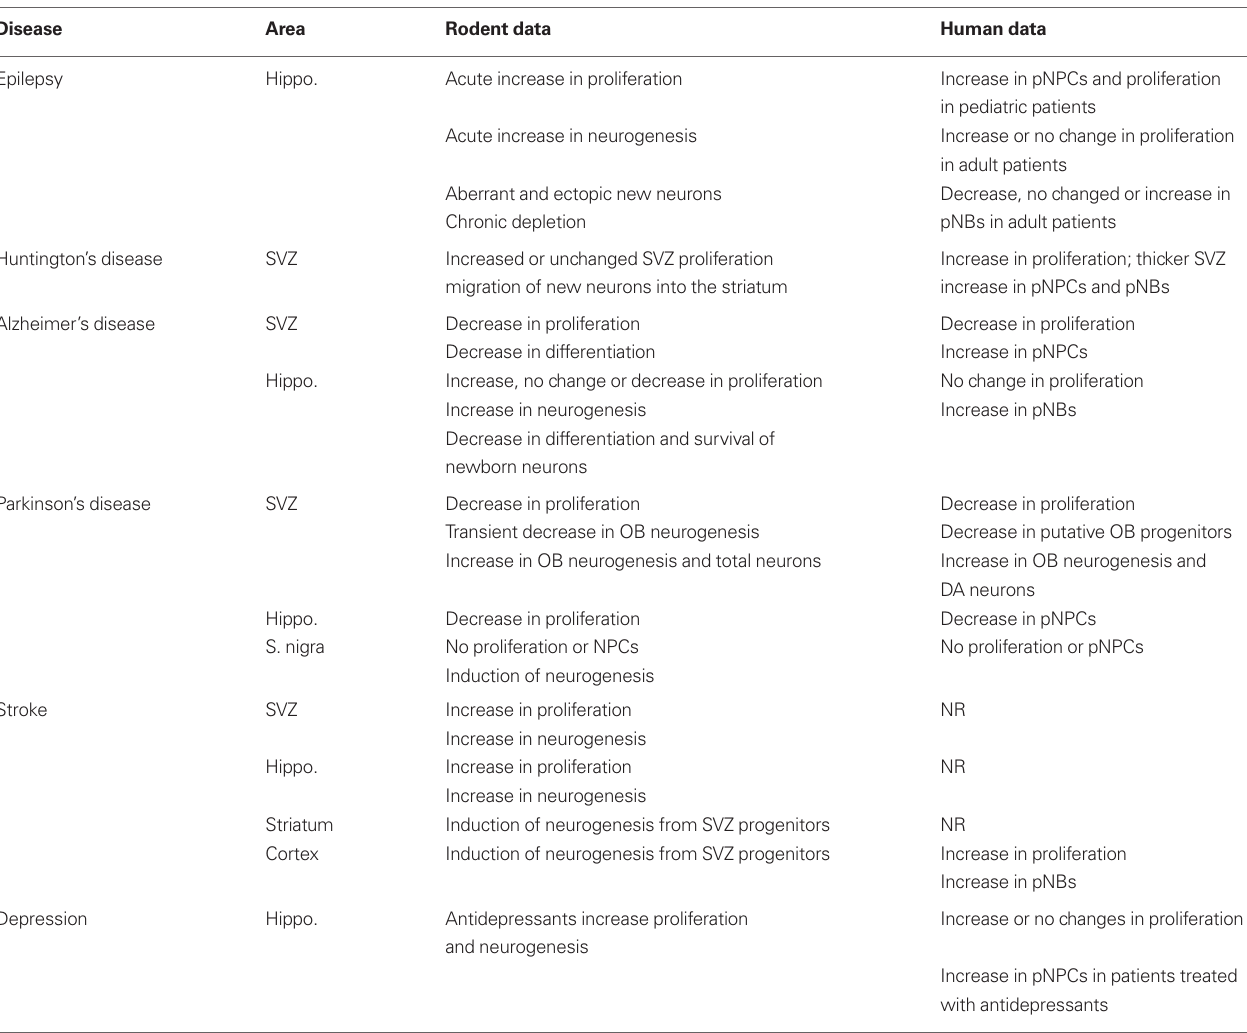
Table 2 | Adult neurogenesis during disease.